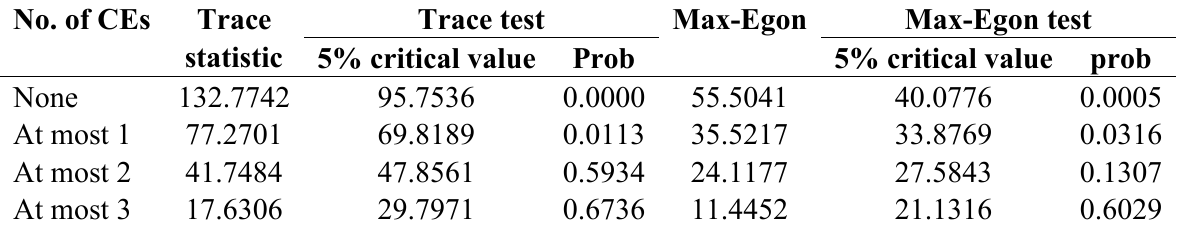
Table 2. Results of the Johansen test for